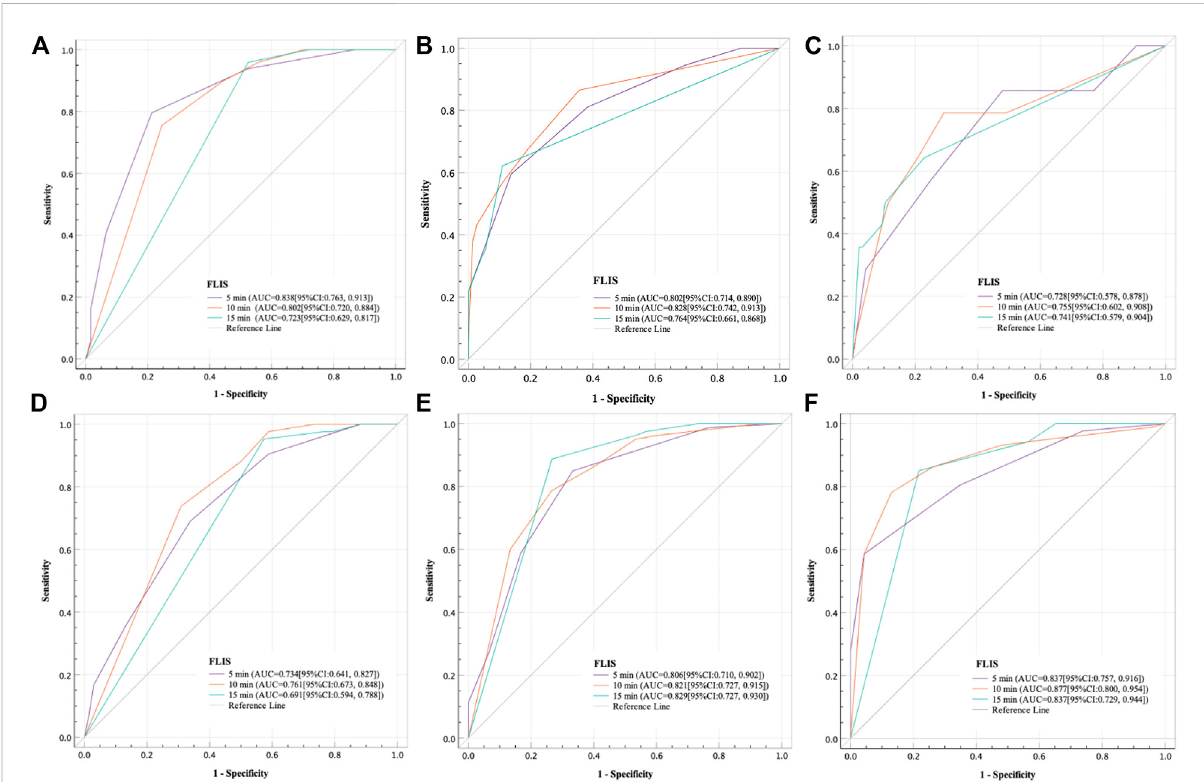
FIGURE 4 Receiver operating characteristic curve analysis of the FLIS for the purpose of (A) predicting ICG-R 15 ≤ 10%, (B) predicting ICG-R 15 > 20%, (C) predicting ICG-R model for end-stage liver